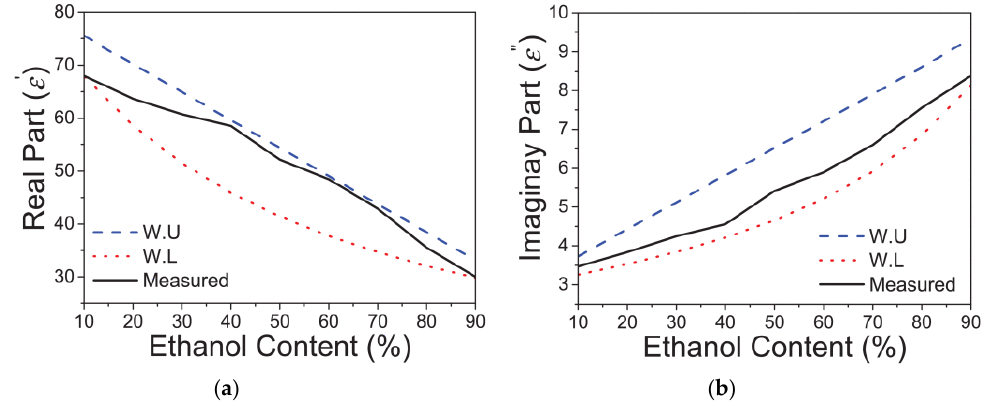
Figure 25. Real ( a ) and imaginary ( b ) part of the complex dielectric constant of water – ethanol solutions as a function of the ethanol content, inferred from the data of Figure 24 and the mathematical model developed in [58]. From [58], reprinted with permission.